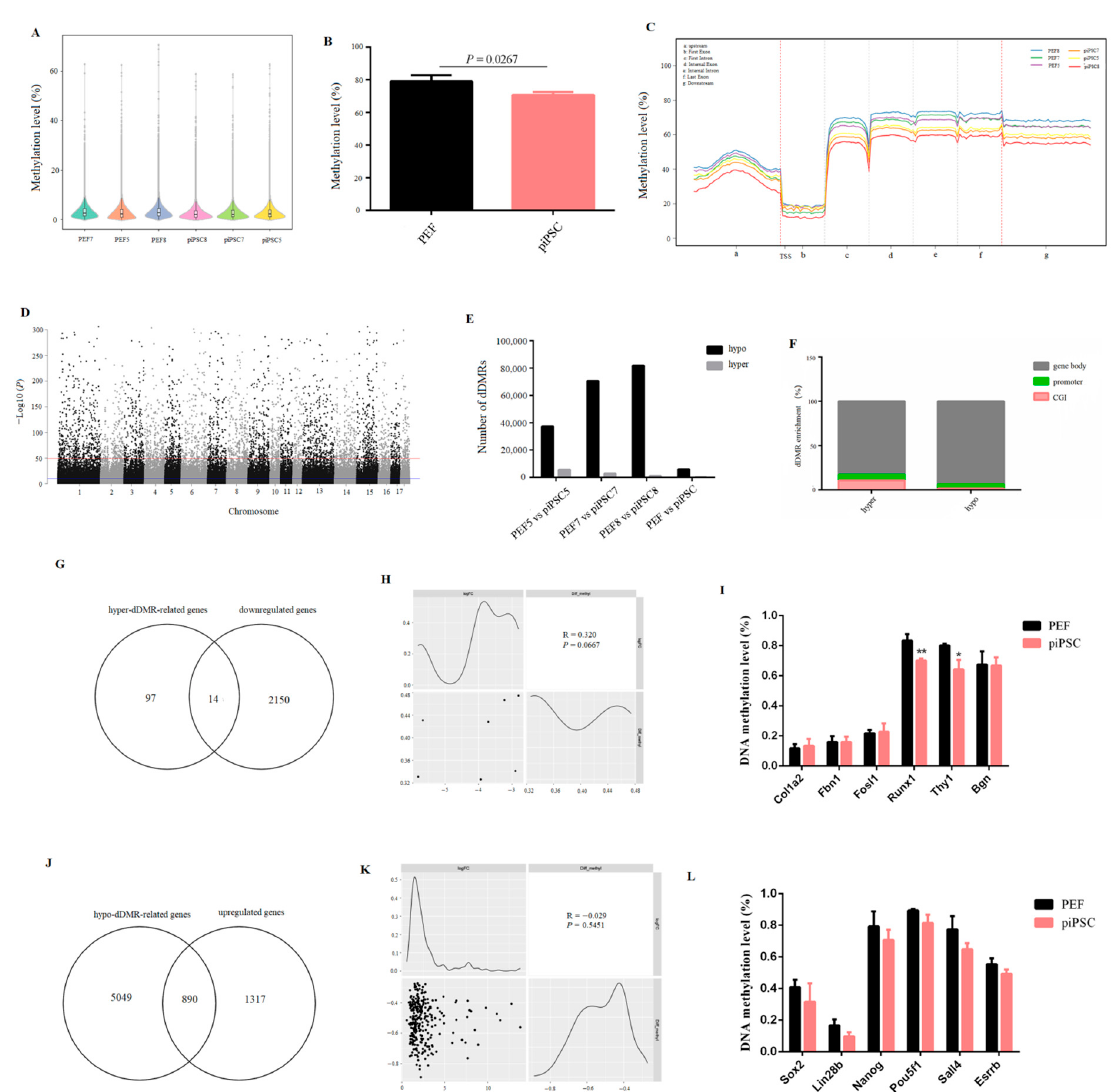
Figure 4. The global DNA methylation level was reduced after reprogramming. ( A , B ) The changes in genome-wide DNA methylation level after reprogramming. ( C ) Map of DNA methylation level in transcription elements. ( D ) Manhattan plot of the genome-wide P -values for the association between the methylation level and reprogramming. ( E ) Numbers of dDMRs in each group. ( F ) The distribution of dDMRs in functional elements. ( G ) Venn diagram between downregulated genes and hyper-dDMR-related genes after reprogramming. ( H ) Correlation analysis showing the relationship between downregulated genes and hyper-dDMRs in promoter. ( I ) The changes in DNA methylation level in PEF-specific genes after reprogramming. * p < 0.05, ** p < 0.01. ( J ) Venn diagram between upregulated genes and hypo-dDMR-related genes after reprogramming. ( K ) Correlation analysis showing the relationship between upregulated genes and hypo-dDMRs in promoter. ( L ) The changes of DNA methylation level in pluripotency genes after